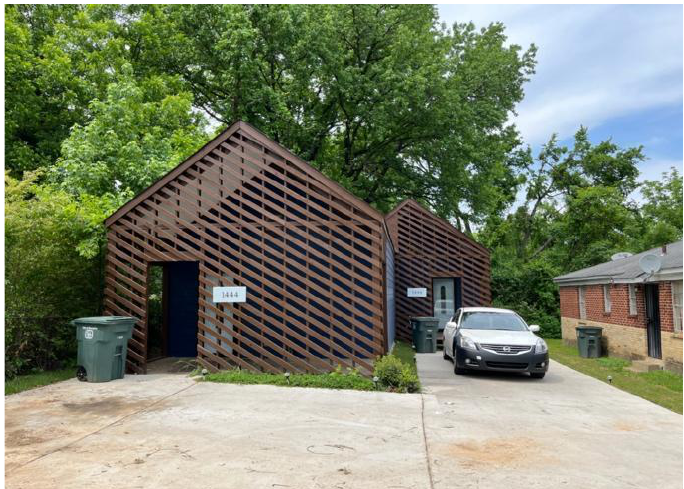
Figure 2. Two new tiny homes were designed pro bono by the Indianapolis-based architecture firm, DKGR, who first heard about MSH’s work through its online platforms. Construction was completed in 2022.